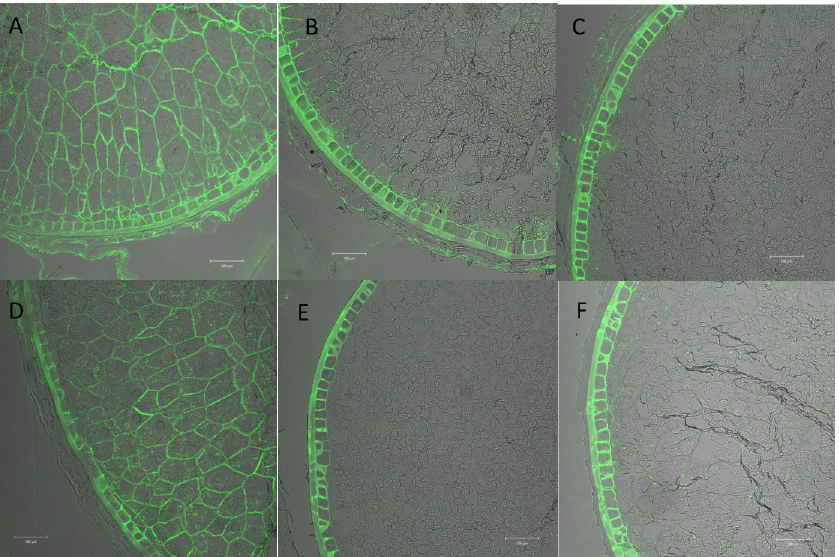
Fig 2. Immunolabelling of medial transverse sections of developing grain at 15 DAA of control and transgenic lines using the monoclonal antibody LM11 to show the amount and distribution of arabinoxylan. A-C, comparison of the null line N1 (A) and the GT43_1 RNAi lines T1 (B) and T5 (C); D-F, comparison of the control line C1 with the triple transgenic lines (GT43_1+GT43_2+GT47_2 RNAi constructs) T7 (E) and T8 (F). Bar—100 μ m. RNAi lines (T1 and T5) (panels B and C) and two triple transgenic lines (T7, T8) (panels E, F) showed reduced labelling of the cell walls in the starchy endosperm, but not the aleurone layer, compared to the respective control lines (panels A and D), but no obvious differences in the intensity of labelling between the GT43_1 and triple lines. This is consistent with the tissue- specificity of the HMW subunit promoter used to drive the RNAi constructs and the similar levels of suppression of TOT-AX in the two sets of lines (Table 2).